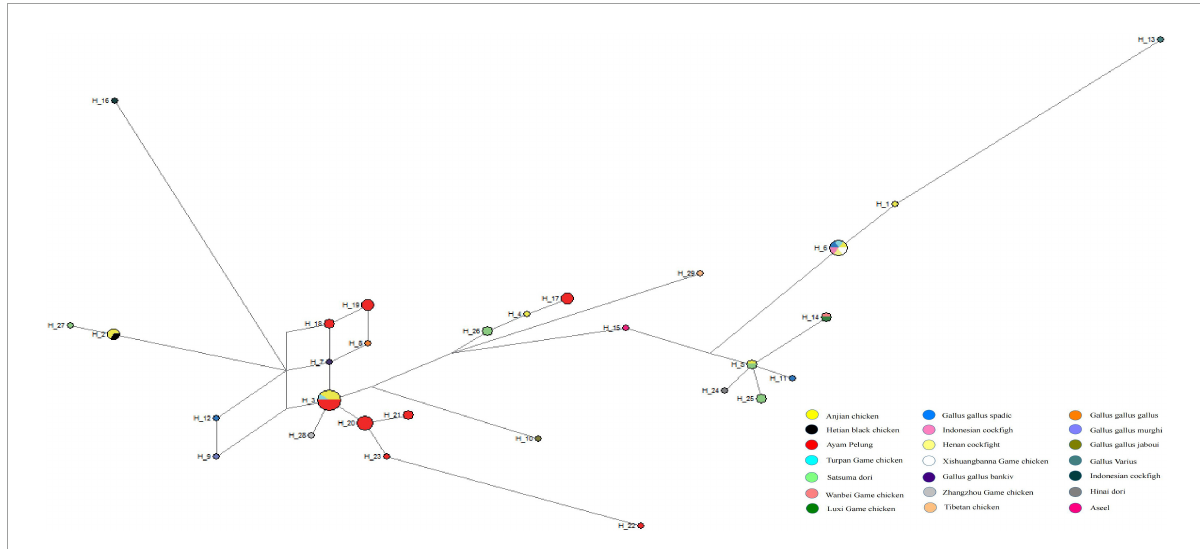
FIGURE6 Median connectivity network based on the D-loop DNA sequences of 29 haplotypes from 20 chicken breeds. Each population is represented by different colors and shows the proportion of different populations in each haplotype. A breed of turkey (EF153719.1) was selected as the